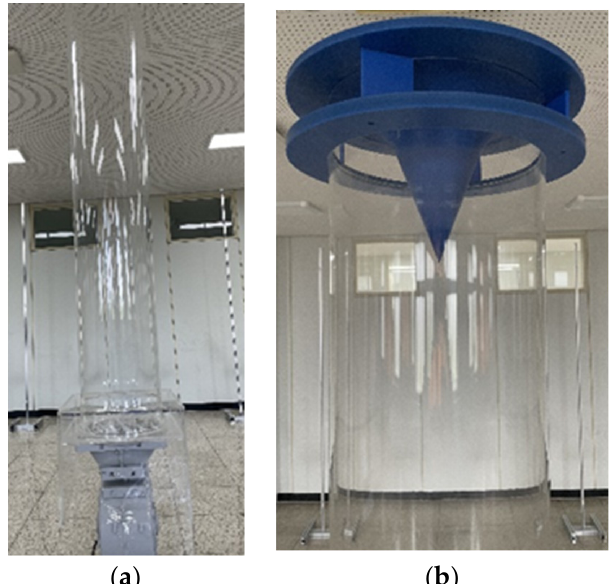
Figure 9. Air circulation system prototype. ( a ) Circular outlet shape; ( b ) Optimized outlet shape.